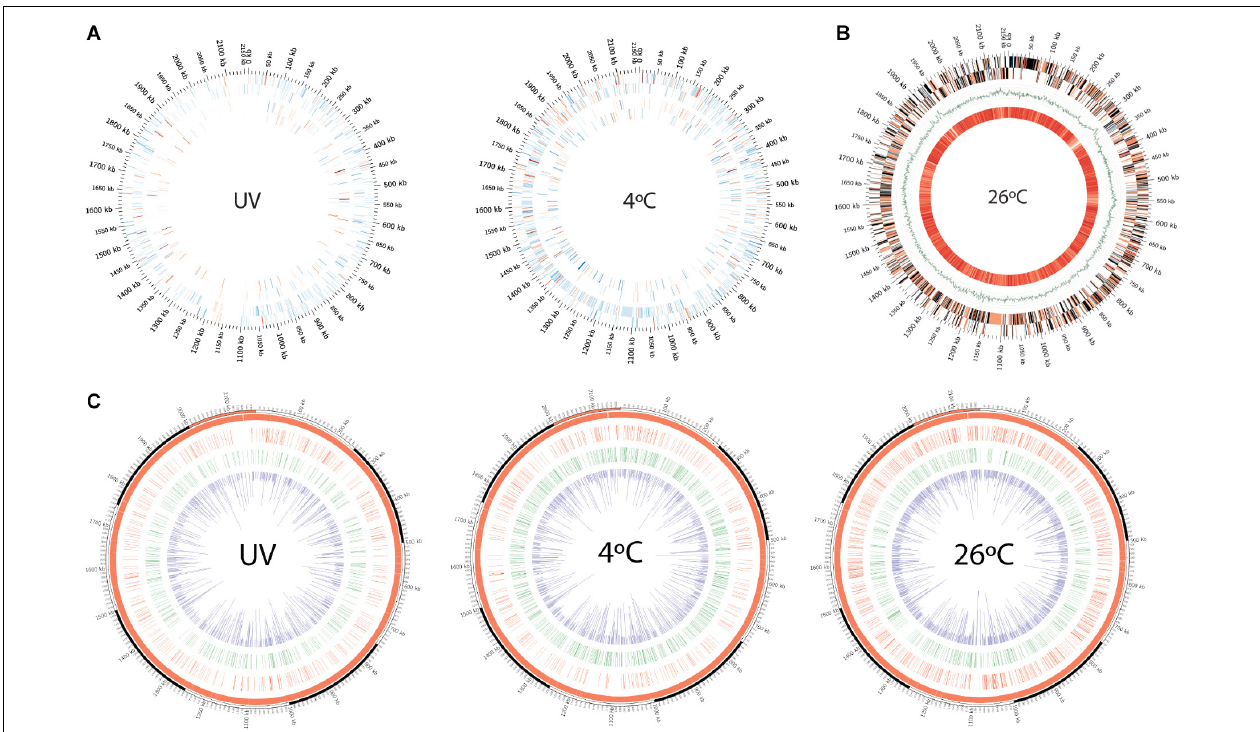
FIGURE 2 | (A) Circos plot depiction of differentially expressed genes and proteins in cold treatment and UV-irradiated bacterial samples compared against 26 ◦ C treatment, as revealed by microarray and LC-MS. Outermost tick marks: bacterial genome of 2.15-Mb. Concentric tracks from outer to inner: sense and antisense strand, respectively. (B) Circos plot representation of differentially expressed genes in bacteria incubated at 26 ◦ C (in relative comparison to 4 ◦ C-incubated cells) and averaged melting energy distribution in bacterial genome. The outer two concentric tracks represent sense and antisense strands. Color-coding: red (up-regulated genes) with transient color (expressed transcript gradients) toward blue (down-regulated genes), black genes are undetected in microarray analysis. Green GC skew curve is then followed with the innermost track, representing average negative DNA melting energy with 100-kb scanning window size (bright orange to pale yellow represent high to low values). (C) Circos plots showing the kinetic variation measured as IPD ratio recorded across the Polynucleobacter asymbioticus strain QLW-P1DMWA-1 T genome. Red and green tracks represent the genome locations where 4mC and 6mA modification motifs were recorded, respectively. Inner (purple) track: IPD ratios of the corresponding modifications recorded across the